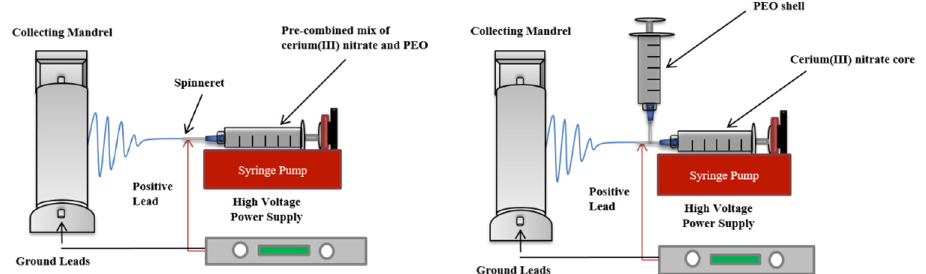
Figure 1. Electrospinning process orientations. Traditional spinning with one solution ( left ) and coaxial encapsulation ( right ). coaxial encapsulation ( right